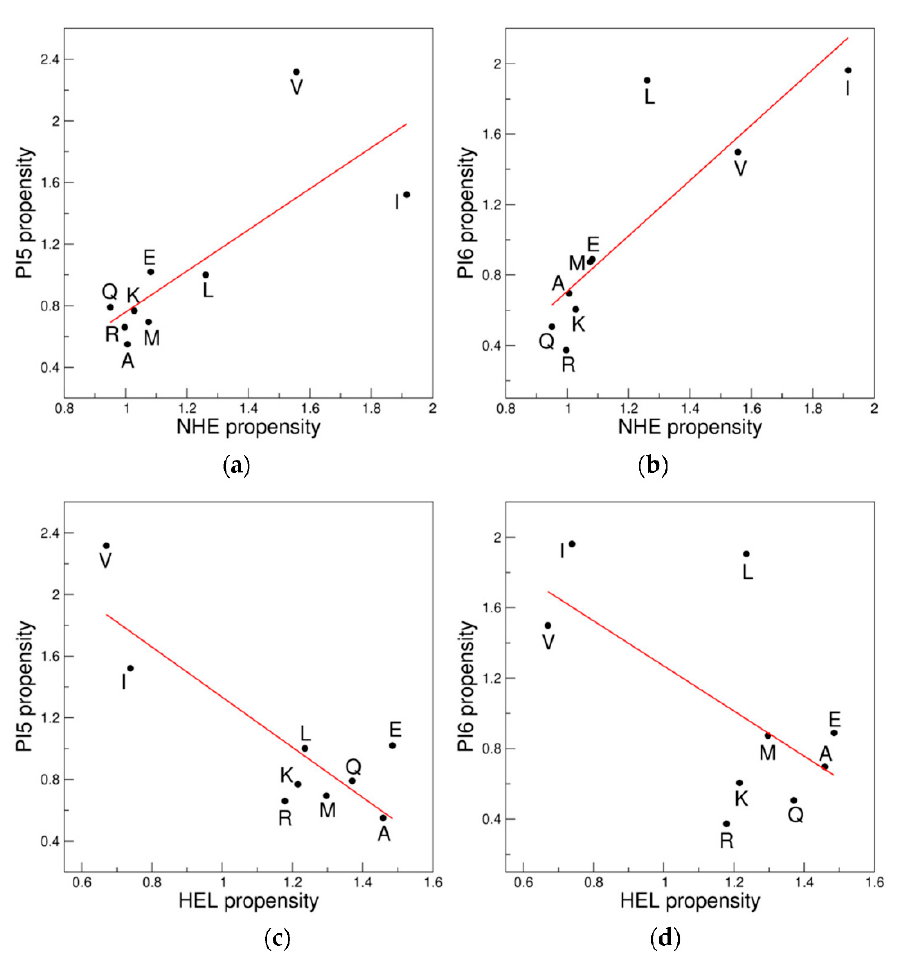
Figure 5. Correlations of the propensity scales for NHE/HEL and positions five (PI5) or six (PI6) of π -helices: ( a ) NHE versus PI5; ( b ) NHE versus PI6; ( c ) HEL versus PI5; and ( d ) HEL versus PI6. The 9AA ensemble is considered.